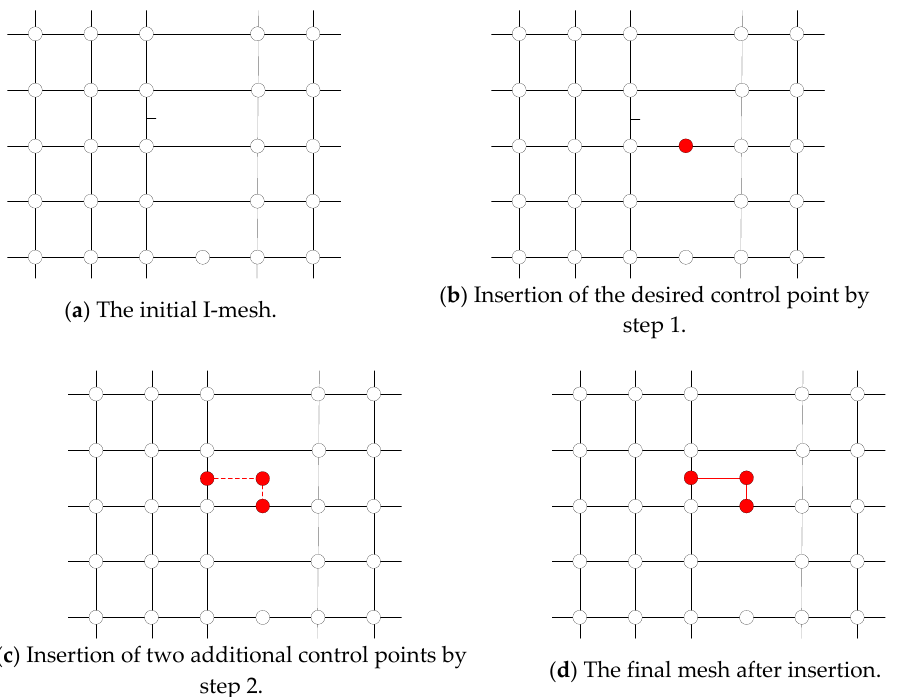
Figure 9. Control point insertion in another 2D I-spline topology.